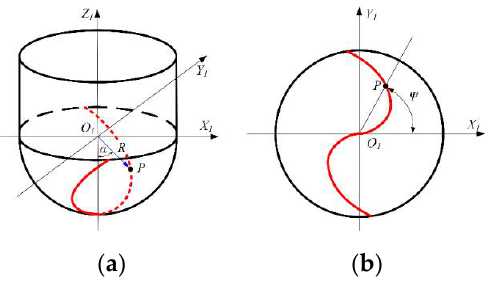
Figure 1. Tool coordinate system of ball-end milling cutter. ( a ) Cutting edge of the ball portion; ( b ) The projection of the cutting edge on the XOY plane.